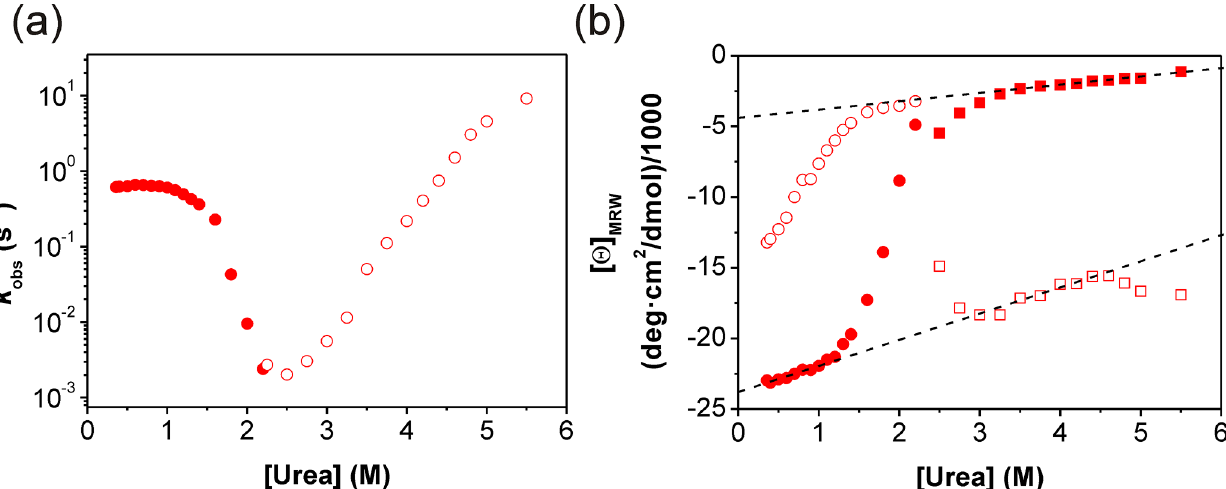
Fig 9. Chevron plot and end point analysis for the far-UV CD detected un- and refolding kinetics. Un- and refolding kinetics of N-BAR measured by far- UV circular dichroismn as a function of the urea concentration. (a) Chevron-plot of the apparent rate constants. Filled symbols represent refolding kinetics while open symbols stand for unfolding kinetics. (b) Analysis of the endpoints from refolding (circles) and unfolding measurements (squares). Closed symbols represent the final signal and open symbols the initial